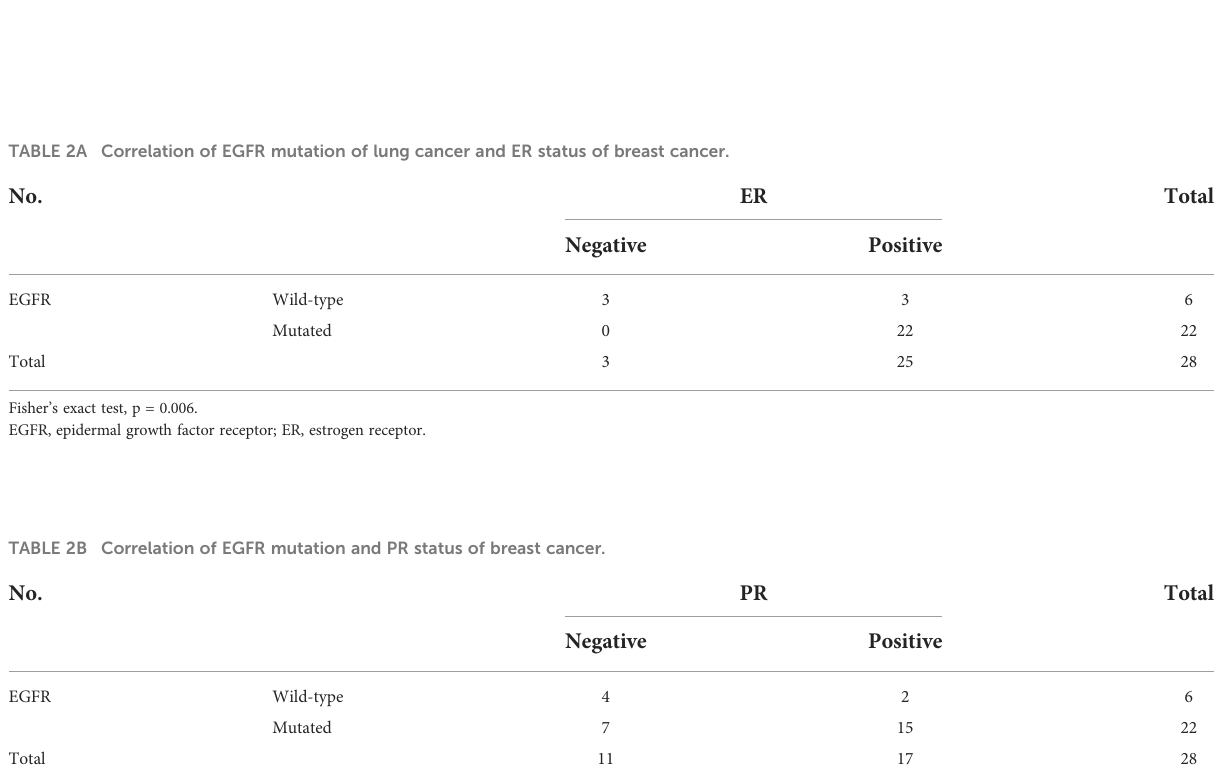
EGFR Wild-type 4 2 6 Mutated 7 15 22 Total 11 17